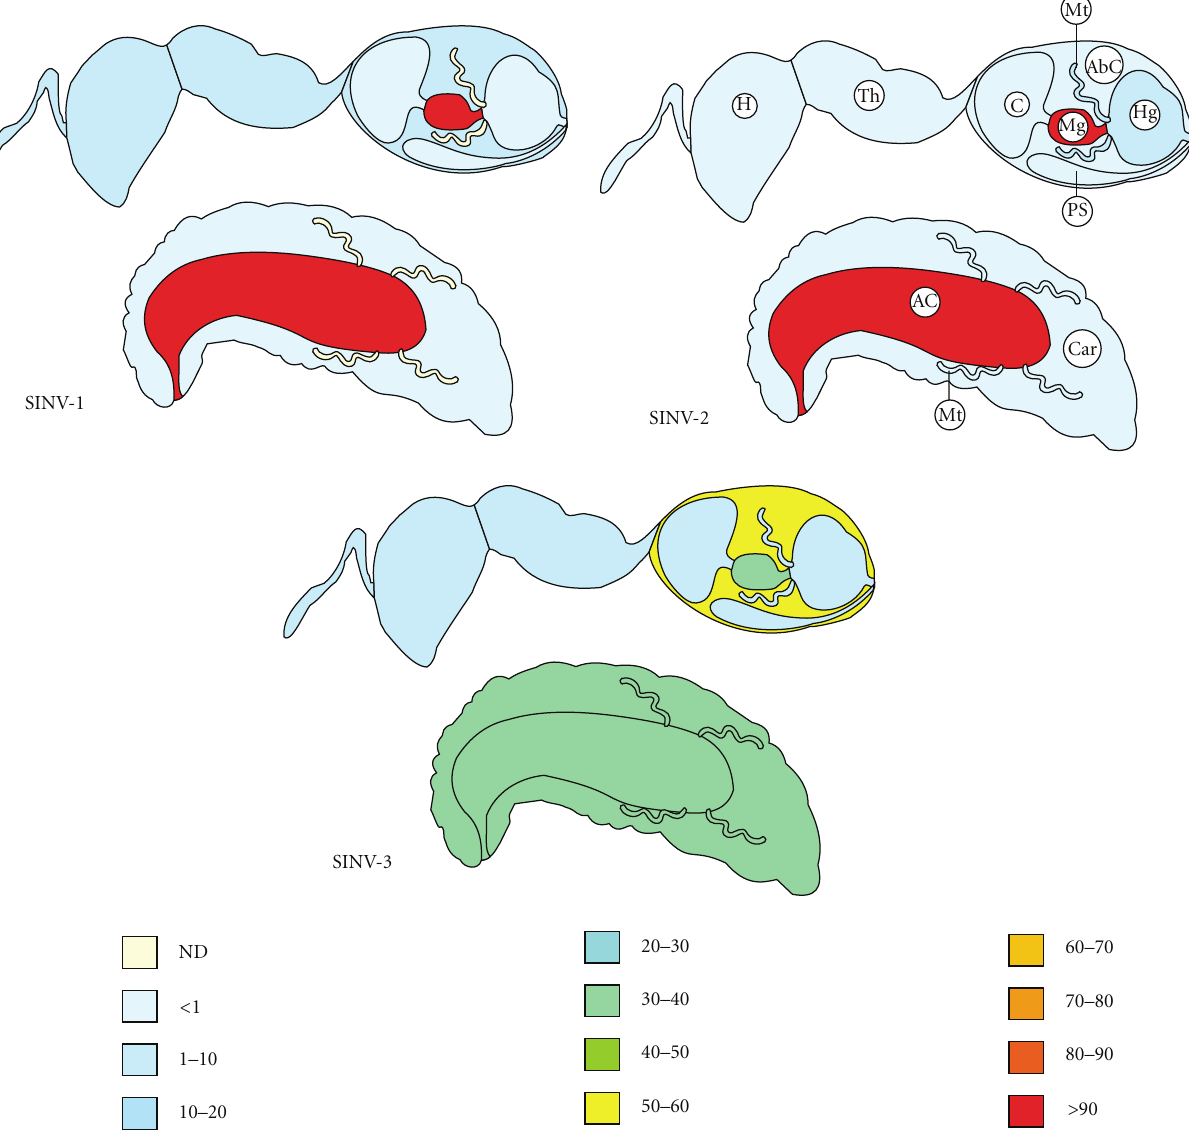
Figure 4: Tissue tropism of SINV-1, SINV-2, and SINV-3 among larval and worker S. invicta ants. Virus was quantified by real-time PCR. Color key reflects the proportion of the total for each virus detected in each tissue. (ND = not detected). Tissue key is identical for all viruses, H: head; Th: thorax; C: crop; Mg: midgut; Hg: hindgut; PS: poison sac; Mt: Malpighian tubules; AbC: abdominal carcass, AC: alimentary canal; Car: